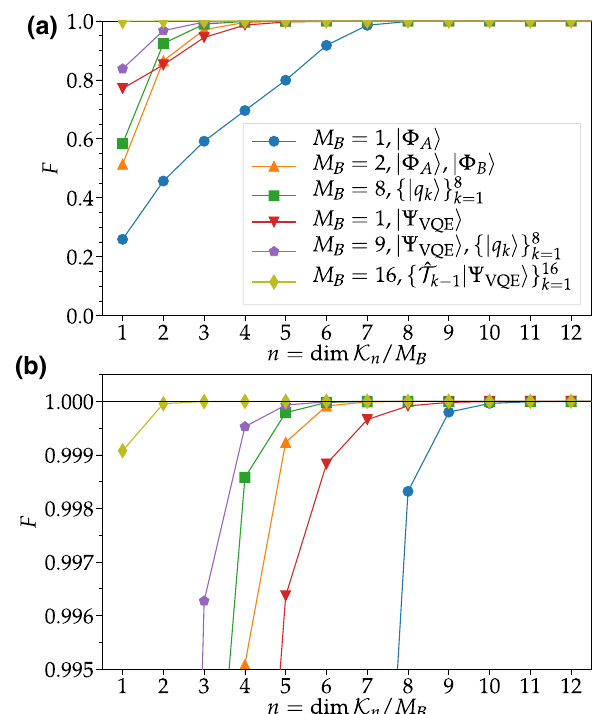
FIG. 6. (a) Same as Fig. 5(a) but for the ground-state fidelity F = |(cid:9) (cid:6) 0 | (cid:6) KS (cid:3)| 2 . Here, | (cid:6) 0 (cid:3) is the exact ground state and | (cid:6) KS (cid:3) is the approximate ground state with the corresponding energy E KS shown in Fig. 5. Both states are assumed to be normalized. (b) Enlarged plot of